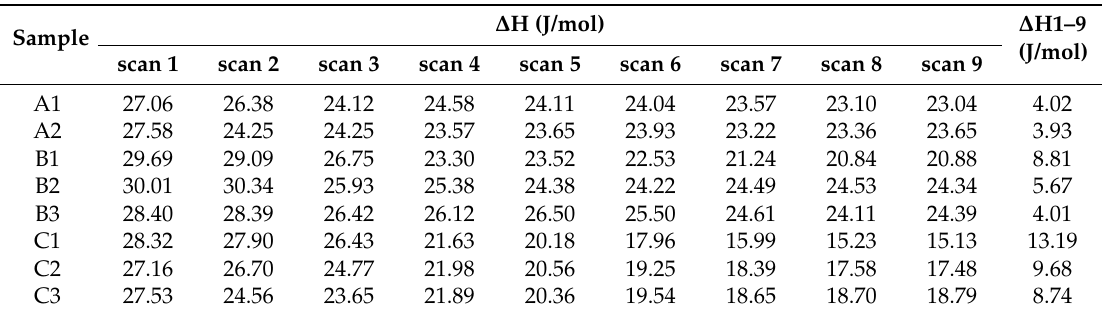
Table 3. Enthalpy change ( ∆ H) values determined for each DSC scan during in vitro experiments on IDE-loaded SLN interactions with MLV liposomes and ∆ H difference between scan 1 and scan 9 ( ∆ H1–9).